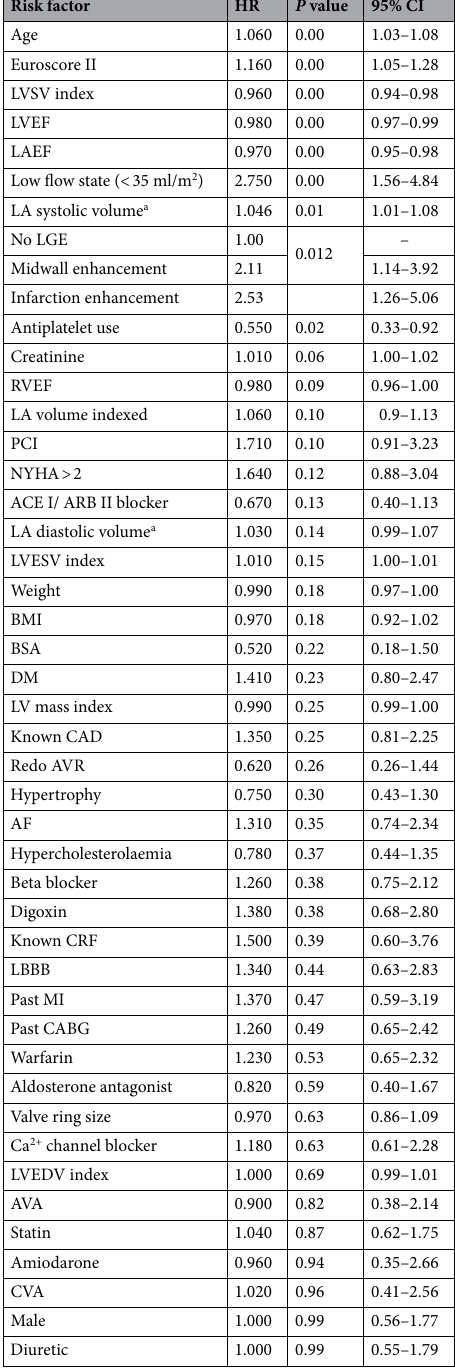
Table 2. Cox proportional hazard model univariable analysis of potential predictors of mortality following SAVR. A stepwise forward selection was used, allowing us to investigate multiple variables. From these we identified the six variables showing the strongest prediction which we included in the final model. This model showed only mild overfitting which was nonetheless adjusted for. a Per 10-unit